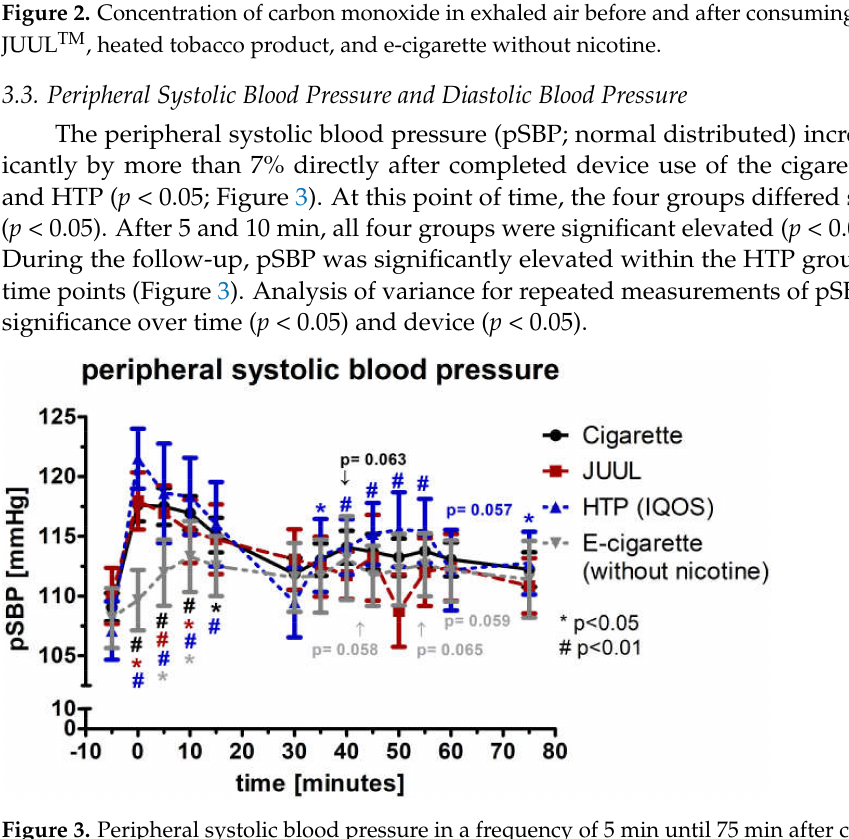
Figure 3. Peripheral systolic blood pressure in a frequency of 5 min until 75 min after consuming the cigarette, JUUL TM , heated tobacco product, and e-cigarette without nicotine. There was a significant increase in the peripheral systolic blood pressure right after the consumption of the cigarette, JUUL™, and heated tobacco